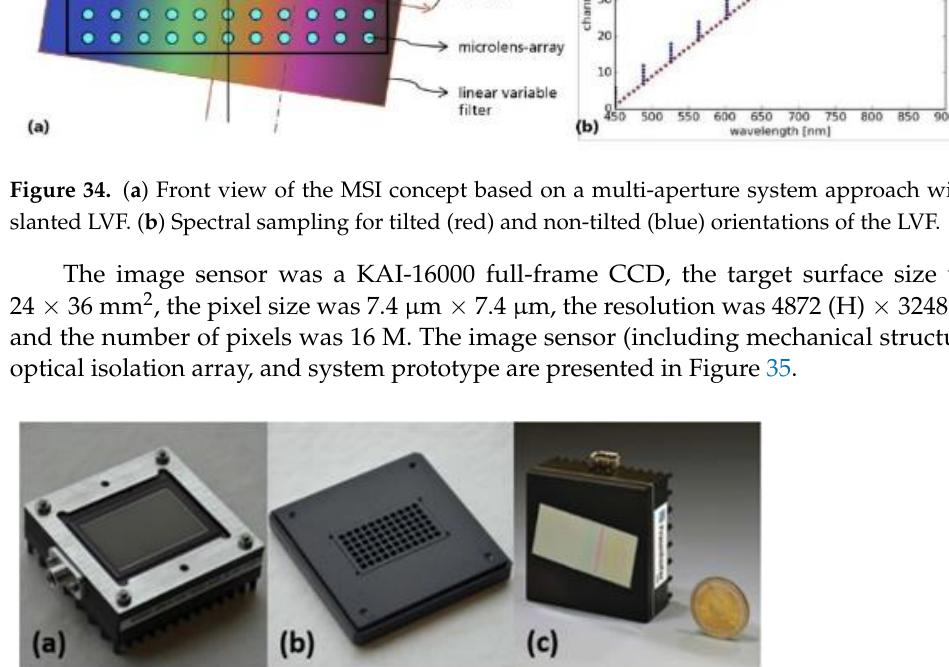
Figure 35. ( a ) Photograph of the KAI-16000 CCD image sensor included in the mechanical housing, ( b ) multispectral micro-optical unit from the bottom view showing the square-shaped holes of the baffle array, and ( c ) size comparison of the complete multispectral camera with a EUR 2 coin. Figure 36a shows the original spectral sub-images obtained using the prototype. Each image channel has a FOV of 68° and a spatial resolution of up to 400 × 400 pixels, spectral sampling at 6 nm steps, and a spectral range of 450 nm~850 nm. Figure 36b depicts the target scenario.